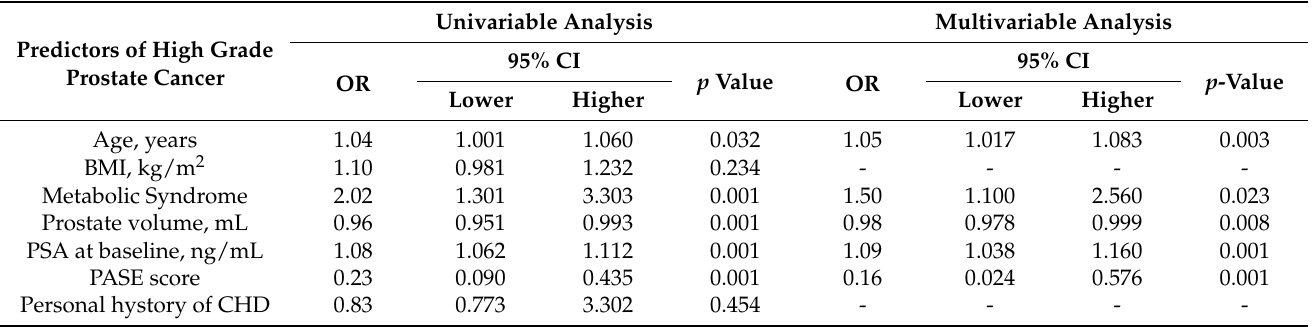
Table 3. Unilabiate and multivariate logistic regression analyses to identify predictors of high grade prostate